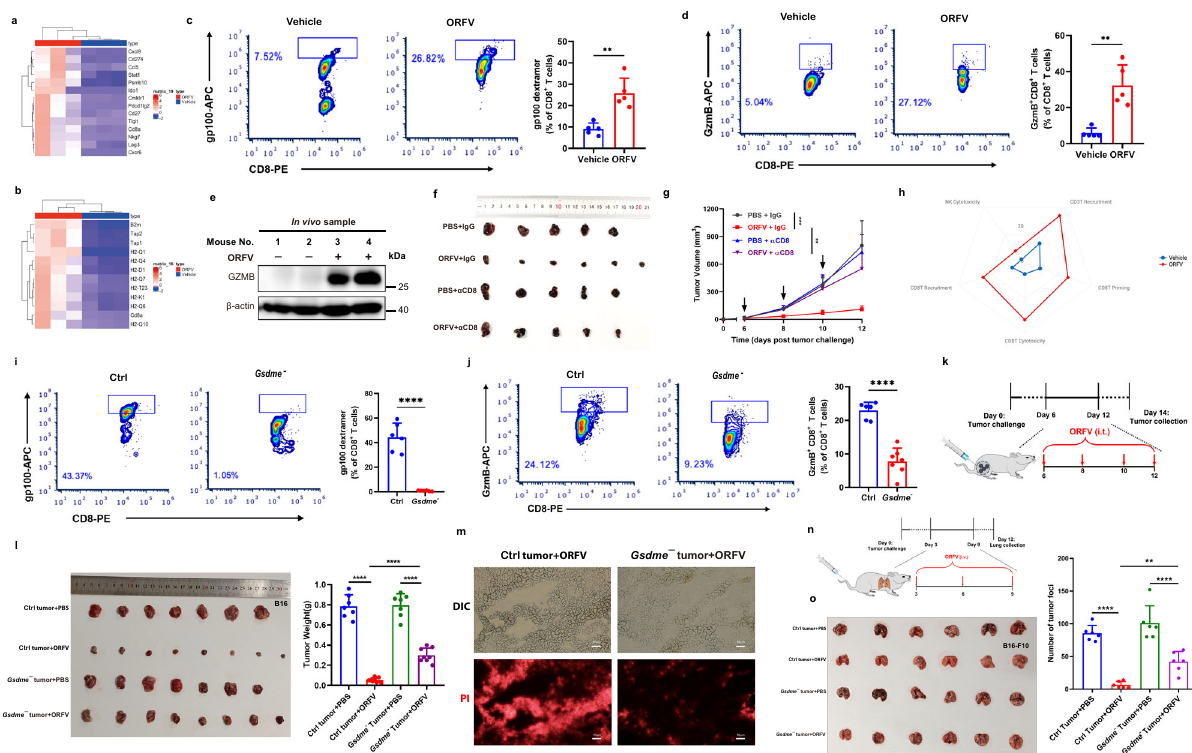
Fig. 4 | GSDME depletion impairs ORFV-induced antitumor immunity. a , b Representative heatmap of ORFV-regulated genes based on NanoString Pan- Cancer immune pro fi ling analysis (26)( a ) and the antigen presentation ( b ). c FACS analysis for the detection of melanoma antigen gp100-speci fi c CD8 + T cells in vehicle or ORFV-treated tumors. Quantitative analysis results are shown on the right ( n =5)( P =0.0011). d FACS analysisfor the detection of GzmB + CD8 + T cellsin vehicle or ORFV-treated tumors. Quantitative analysis results are shown on the right ( n =5)( P =0.0010). e GzmB detection in vehicle or ORFV-treated B16 tumor lysates. f , g Male C57BL/6 mice were s.c. engrafted with B16 cells, then i.t. treated with vehicle, ORFV, an anti-CD8 blocking antibody or ORFV, and the antibody ( n =5 – 6).Tumorvolumeswereshownin( f )and( g ),respectively(*** P =0.0001and ** P =0.0099). h Spiderwebplotshowingthechangesofimmunecellsinthetumor microenvironment after the ORFV challenge. Values represent the percentage of the indicated cells, and the data are the same as those shown for FACS analyses. i , j Mice were engrafted with Ctrl or Gsdme - B16 tumor cells, and dextramer detection of melanoma antigen gp100-speci fi c CD8 + T cells ( i ) ( n =6) ( P